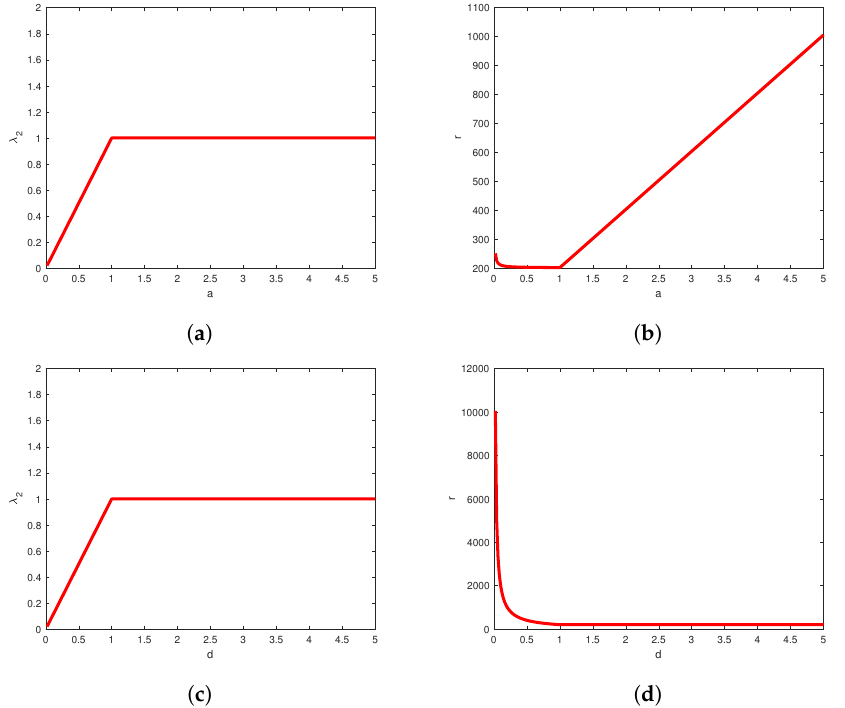
Figure 4. The synchronizability of Networks-A. Panel ( a ) depicts λ 2 vs. a and ( b ) depicts r vs. a when M = 2, η = 100, d = 1; Panel ( c ) depicts λ 2 vs. d and ( d ) depicts r vs. d when M = 2, η = 100, a = 1.